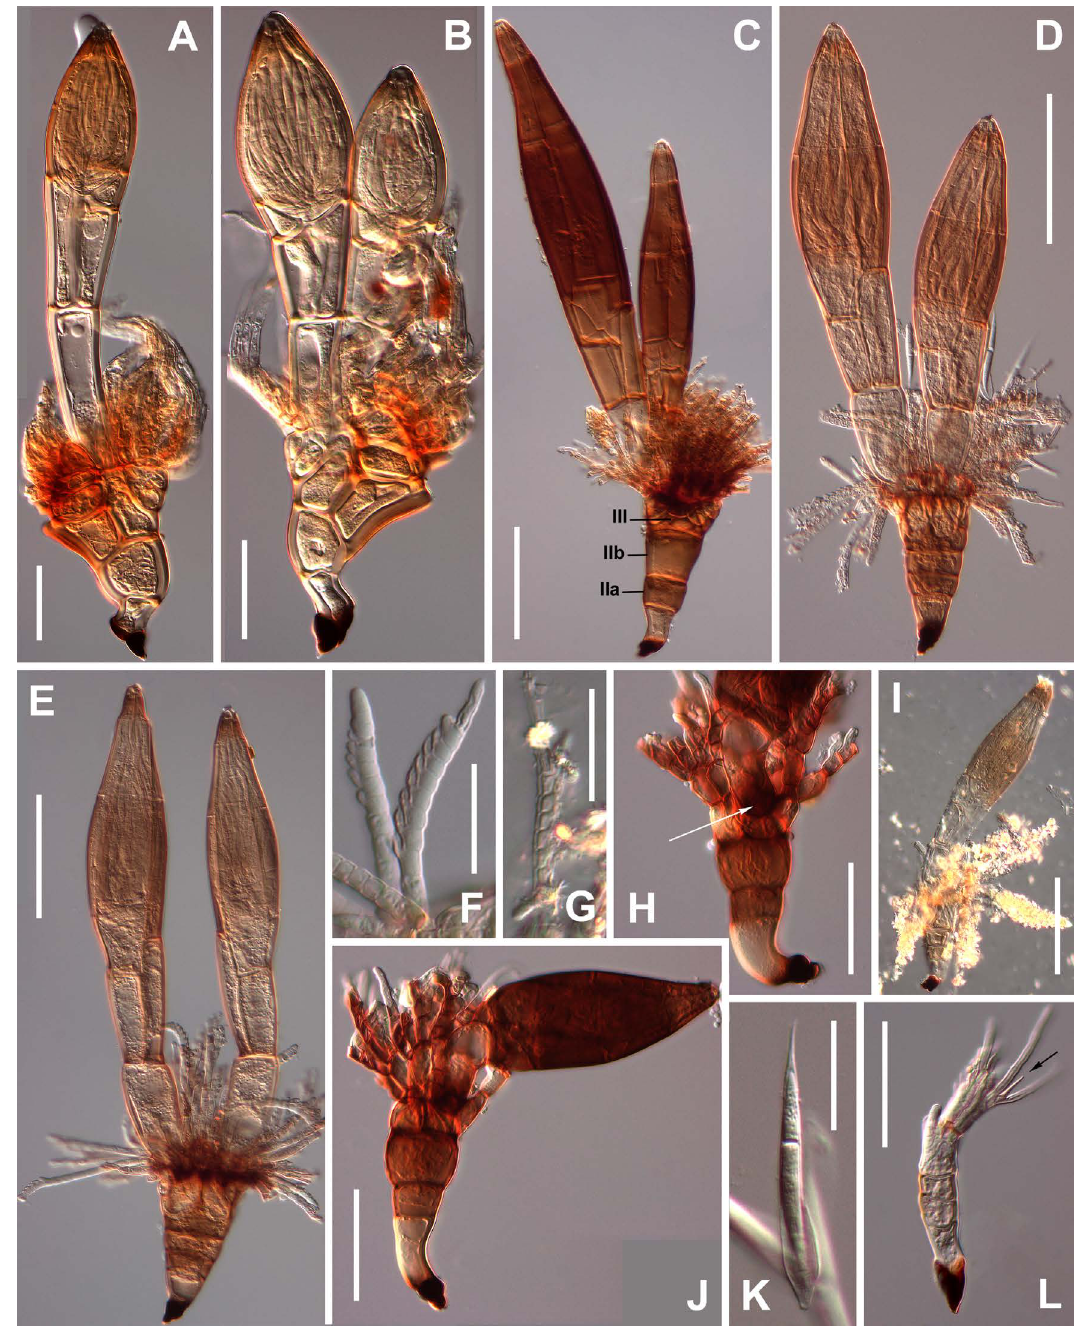
Fig. 14. A – B . Idiomyces peyritschii Thaxt. Mature thalli. – C – L . Symplectromyces vulgaris (Thaxt.) Thaxt. C . Mature thallus from Quedius umbrinus with labelled cells IIa, IIb, and III. D . Mature thallus from Quedius xanthopus . E . Mature thallus from Quedius mesomelinus . F – G . Details of appendages with seriated antheridia (G, in poor condition is from lectotype). H – J . Thalli from Quedius boopoides , with detail of dark cell VI in H (arrow). I. Mature thallus from lectotype slide. K . Ascospore. L . Very young thallus showing ascospore original spinous apex, the sx (arrow). Scale bars: A–B, G–H, J, L = 50 µm; C–E, I = 100 µm; F, K = 25 µm. Photographs from slides ZMUC C-F-122507 (A–B), ZMUC C-F-122498 (C), ZMUC C-F-122679 (D, K), ZMUC C-F-123742 (E–F), FH6581 (lectotype) (G, I), ZMUC C-F-123075 (H, J), ZMUC C-F-123521